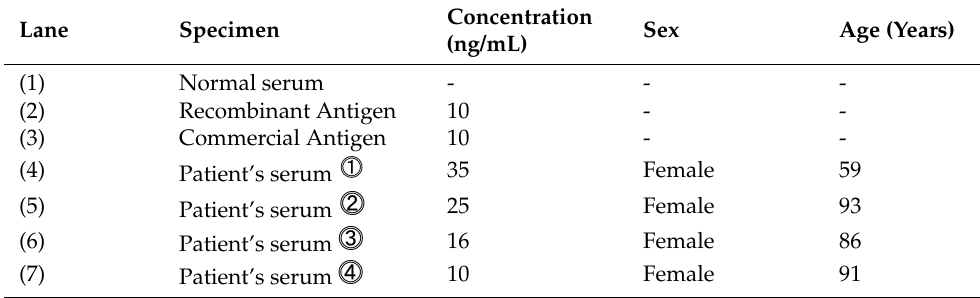
Figure 3. SDS-PAGE analysis of the NT-proBNP recombinant protein. M: protein marker (kDa); L1: supernatant (lysate); L2: filtrate; L3: elution.